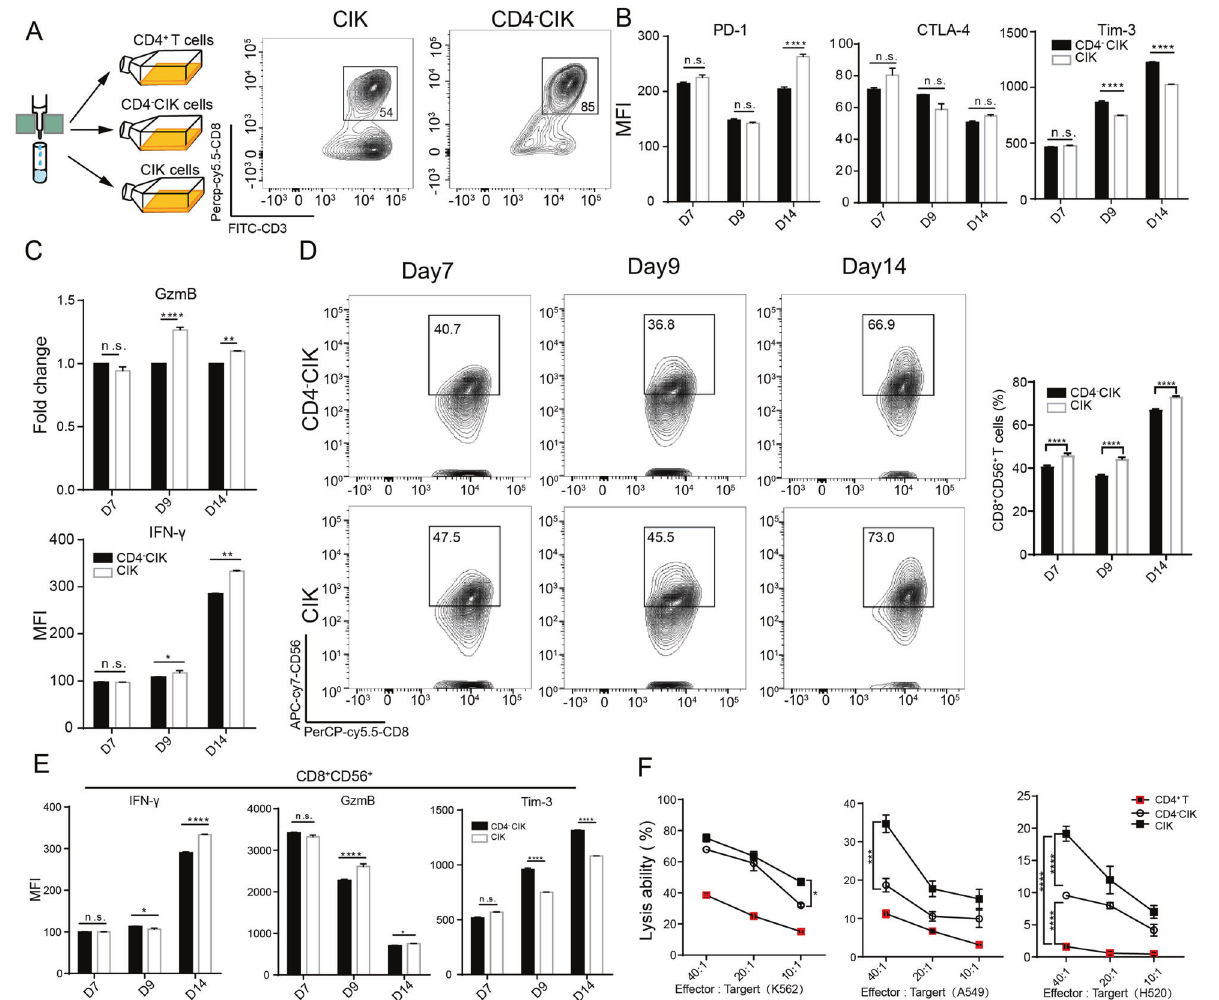
Fig. 3 CD4 + T cells enhanced the function of CIK cells during ex vivo expansion. A Schematic diagram depicting the ex vivo expansion of different CIK cells (left); fl ow cytometric quality assessment of CIK cells when ex vivo expansion at day 14 (right). B Flow cytometric examination of immune checkpoint receptors expression in CD3 + CD8 + T cells. C Flow cytometric analysis of IFN- γ and GzmB production in CD3 + CD8 + T cells. D Flow cytometric examination of the percentage of CD3 + CD8 + CD56 + T cells in CD3 + CD8 + T cells. E Flow cytometric analysis of IFN- γ , GzmB, and Tim-3 expression in CD8 + CD56 + T cells. F The cytotoxicity of CIK, CD4 + T, or CD4 − CIK cells against A549, H520, and K562. Error bars indicate SEM, * P < 0.05, ** P < 0.01, *** P < 0.001, and **** P < 0.0001 (one-way ANOVA or Student's t